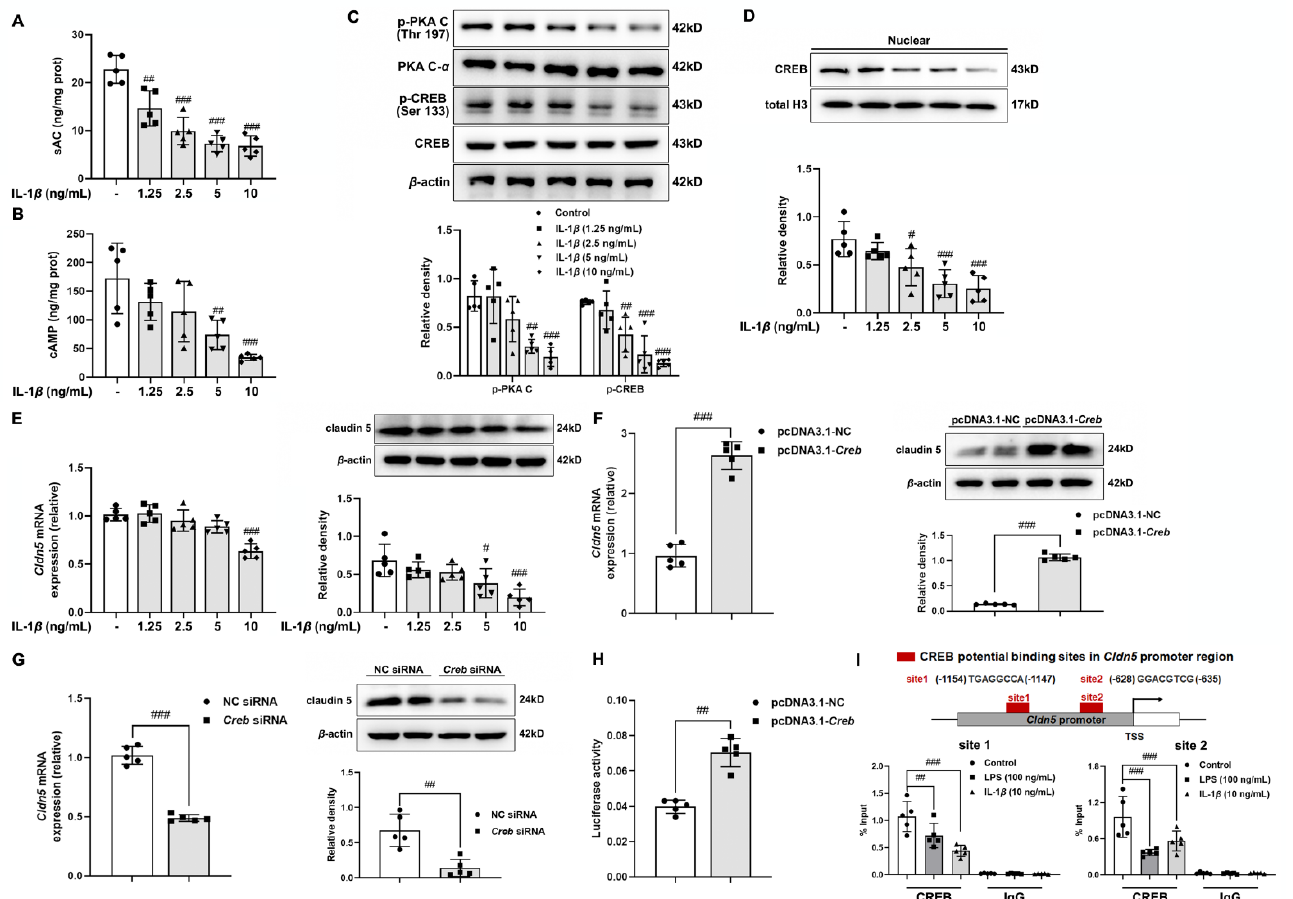
Figure 3. IL-1 β impairs cAMP/CREB cascades to reduce claudin 5 expression in cerebral microvas- cular endothelium. ( A ) sAC and ( B ) cAMP contents were detected in bEnd.3 cells when treated with IL-1 β at the dosage from 1.25 to 10 ng/mL; ( C ) protein expressions of p-PKA C, PKA c- α , and p-CREB (Ser 133) in IL-1 β -stimulated bEnd.3 cells; ( D ) protein expression of CREB in the nucleus of IL-1 β -stimulated bEnd.3 cells; ( E ) gene and protein expression of claudin 5 in bEnd.3 cells when exposed to IL-1 β insult; ( F ) gene and protein expression of claudin 5 in bEnd.3 cells transfected with a plasmid for CREB overexpression ( n = 5); ( G ) gene and protein expression of claudin 5 in bEnd.3 cells transfected with Creb siRNA or NC siRNA ( n = 5); ( H ) bEnd.3 cells were transfected with pcDNA3.1-M_ Creb plasmids, and then the activity of claudin 5 promotors in endothelial cells was measured ( n = 5); ( I ) ChIP-quantitative PCR analyses of CREB binding to Cldn5 promoter in bEnd.3 cells when treated with LPS or IL-1 β stimulation ( n = 5). Data are presented as mean ± SD ( n = 5). # p < 0.05, ## p < 0.01, ### p < 0.001 vs. untreated group or indicated treatment. p values are determined by t -test or one-way ANOVA followed by Tukey’s